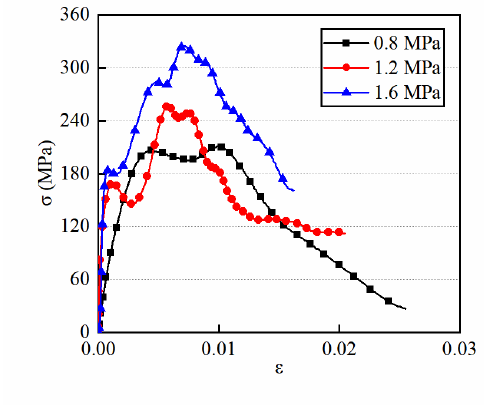
Figure 3. Stress paths and stress−time curves for the samples.